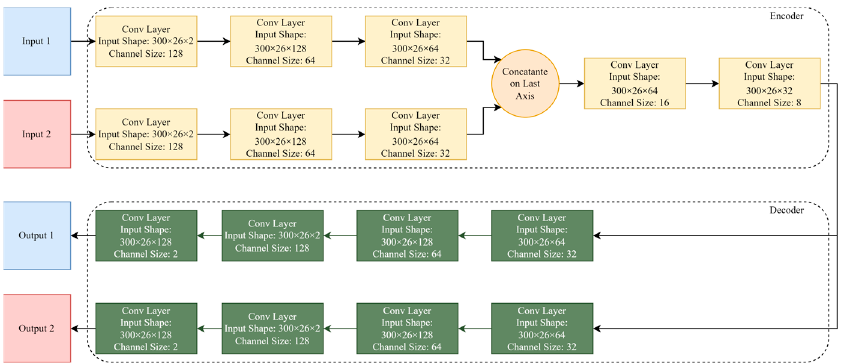
Figure 2. MIMO-AE structure used in this paper, including array sizes and selected hyperparameters and functions.